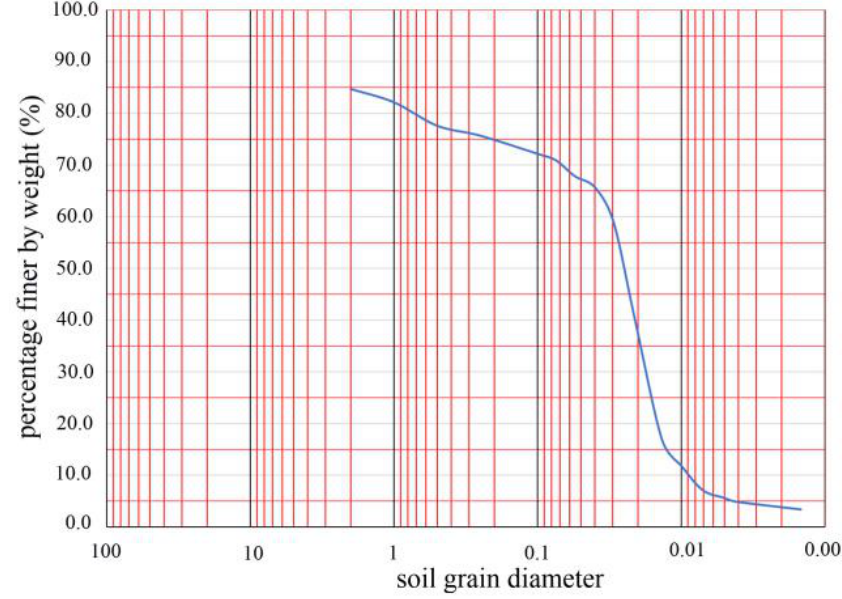
Figure 5. The particle gradation curve of the soil, whose scan color is blue.